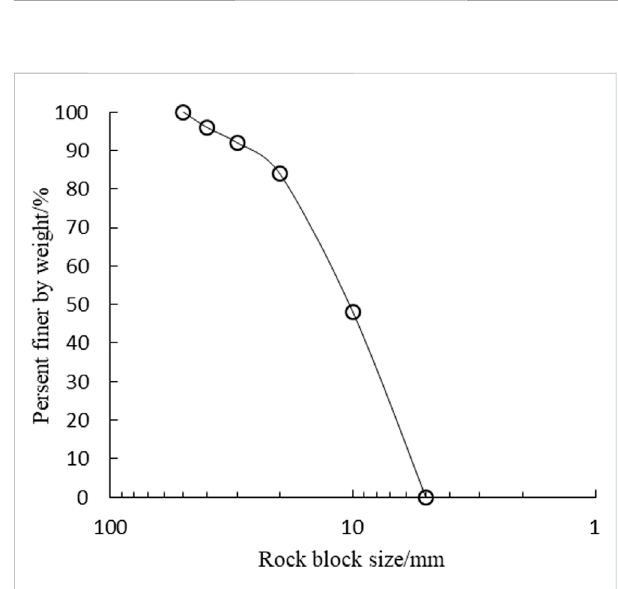
FIGURE 6 The gradation curve of rock